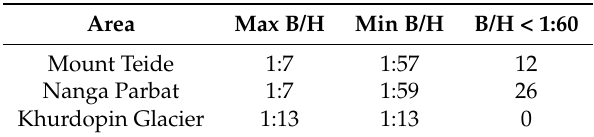
Table 3. Approximate Baseline to Height ratio of the image pairs used for each area. Last column shows the number of image pairs with B/H less than